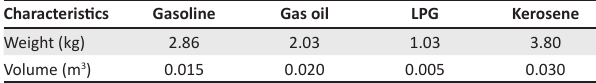
TABLE 4: Refined petroleum product characteristics. Characteristics